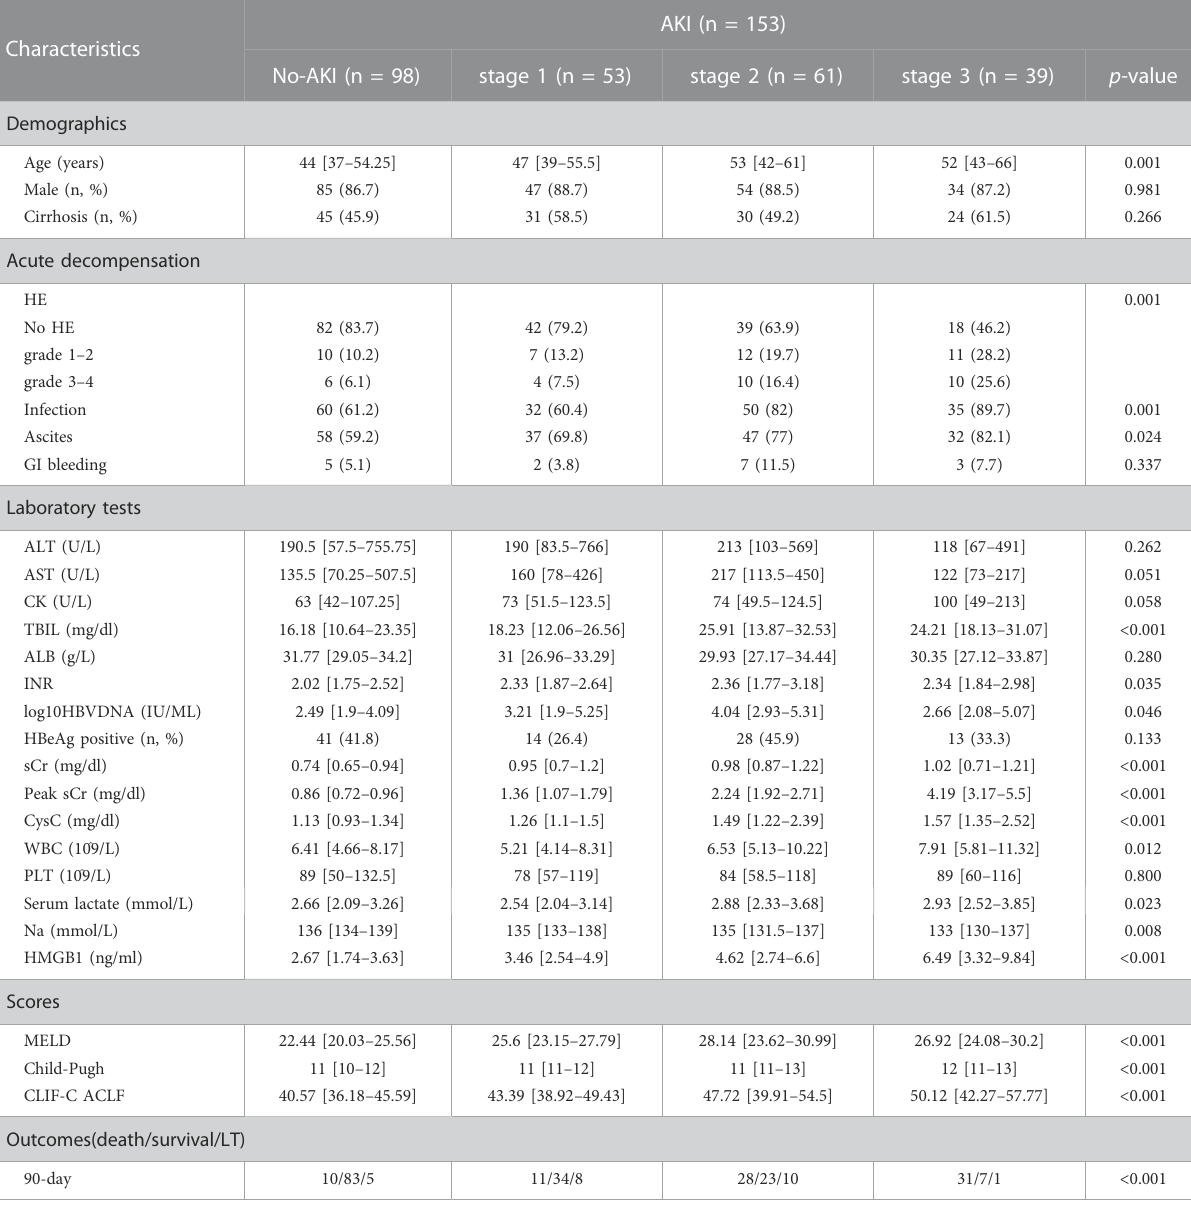
TABLE 1 Baseline demographic and clinical parameters of HBV-ACLF patients with and without AKI according to ICA criteria.